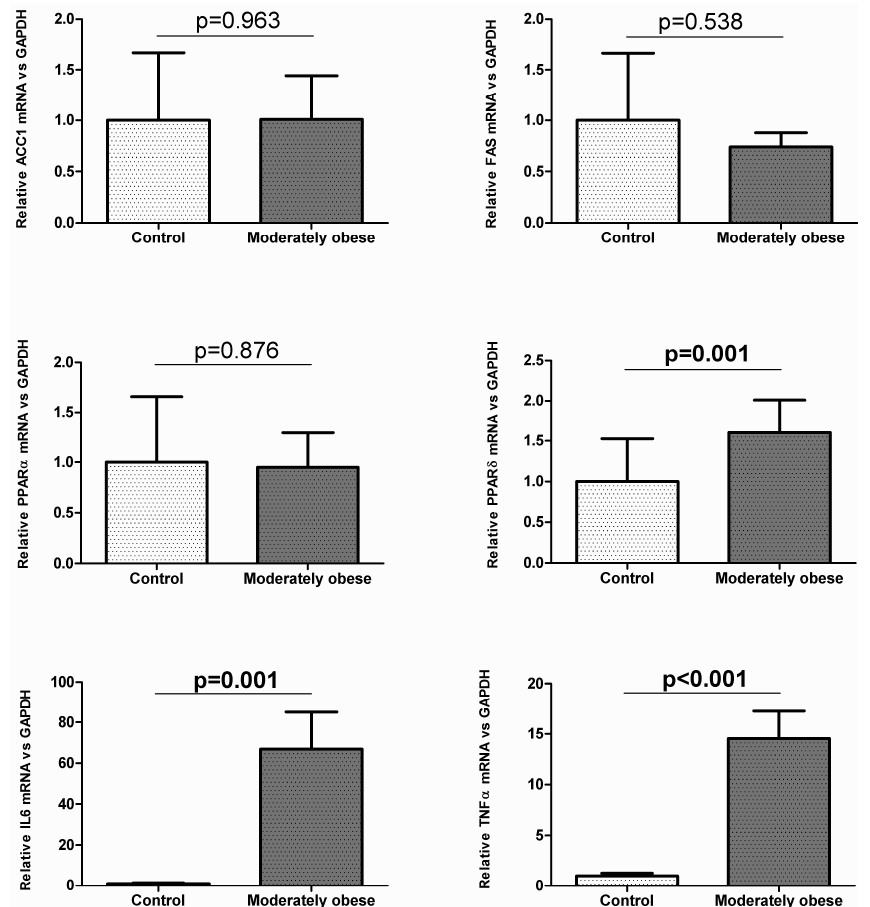
Figure 2. Expression of genes related to lipogenesis, FA oxidation and inflammation in control ( n = 35) and moderately obese women ( n = 55) in visceral adipose tissue. Student’s t -test was used to determinate differences between groups. Data are expressed as mean ± SD. The mRNA expression was calculated relative to the control group, whose mRNA expression was set to 1.0. ACC1, Acetyl-CoA carboxylase 1; FAS, Fatty acid synthase; IL6, Interleukin 6; PPAR α , Peroxisome proliferator-activated receptor alpha; PPAR δ , Peroxisome proliferator-activated receptor delta; TNF α , Tumor necrosis factor alpha.